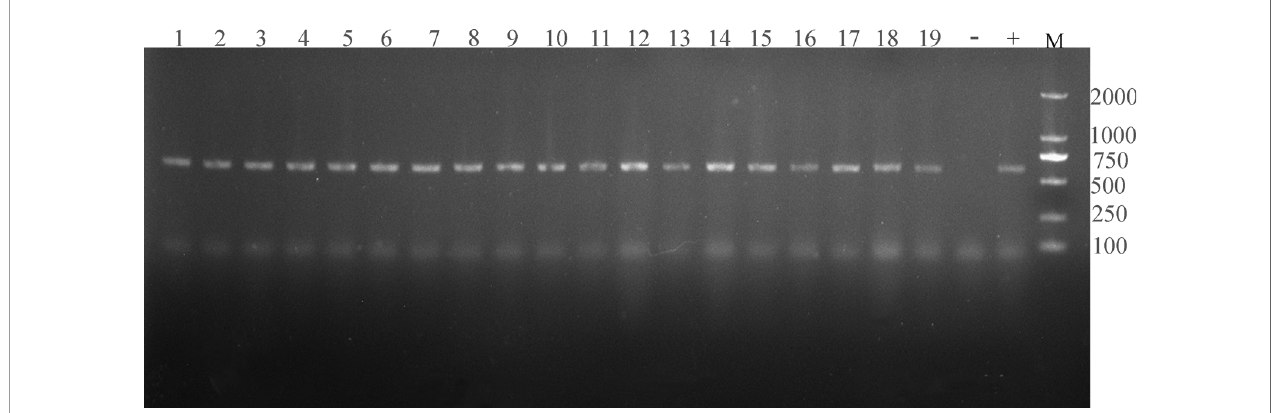
FIGURE 2 | The electropherogram of PCR ampli fi cation of SSU rRNA gene of Cryptosporidium . Lanes 1 – 19 represent TA3, TA9, TA12, TA33, TA61, TA94, TA99, TA103, TA203, TA215, TA217, TA220, TA224, TA230, TA231, TA236, TA241, TA258, and TA301, respectively (19 Cryptosporidium -positive samples); “ - ” represents negative control; “ + ” represents positive control; “ M ” represents DL2000